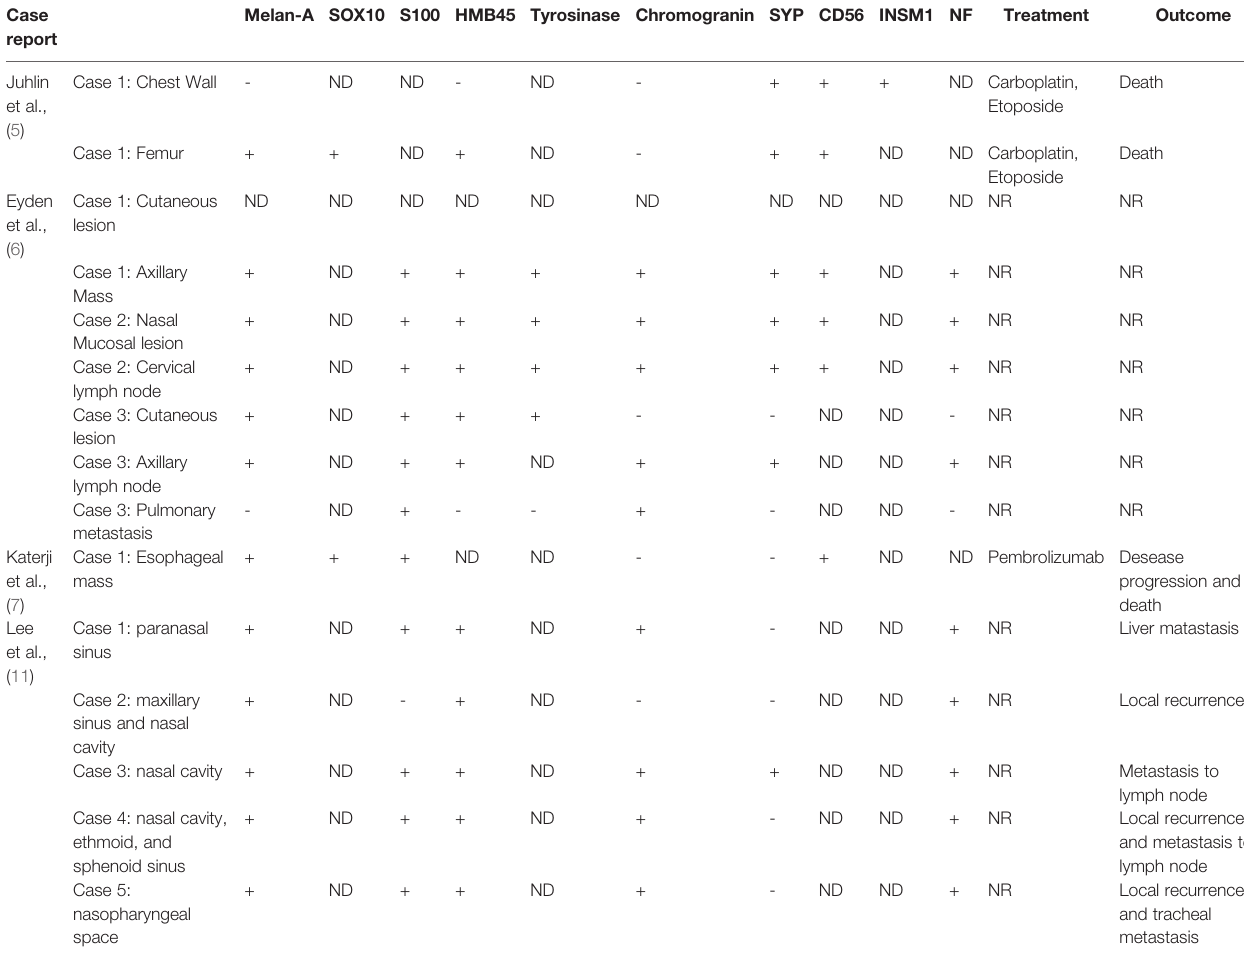
TABLE 1 | Summary of Reported Melanoma Cases with Neuroendocrine Differentiation. Case report